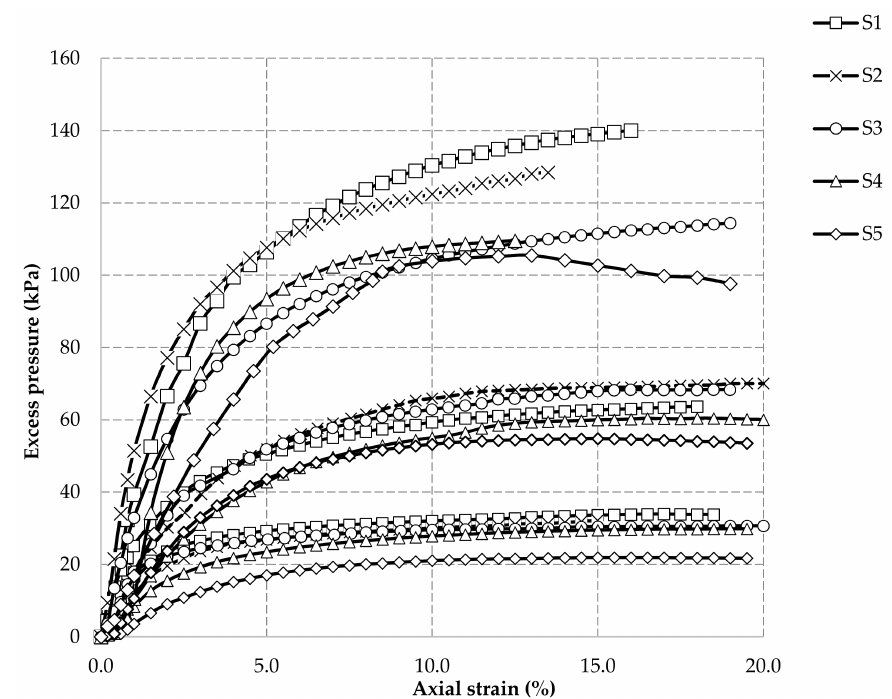
Figure 5. Excess pore pressure versus axial strain with different confining pressures for different silt contents. (S1 represents 100% PoB soft soil; S2 represents 75% PoB soft soil + 25% kaolin soil; S3 represents 50% PoB soft soil + 50% kaolin soil, S4 represents 25% PoB soft soil + 75% kaolin soil; and S5 represents 100% kaolin soil; while 50, 100, and 200 refer to the confining